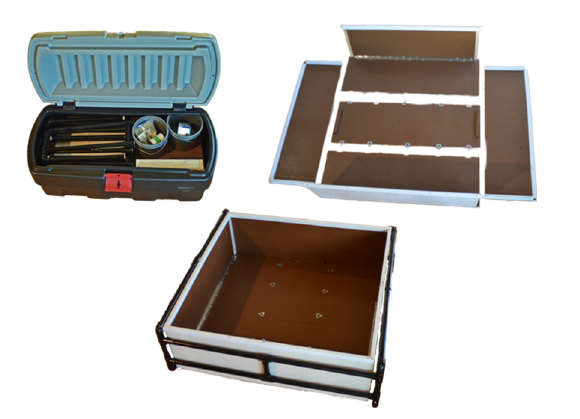
Figure 5: The folding archaeology kit both in its container and fully assembled. Photo by Brendan